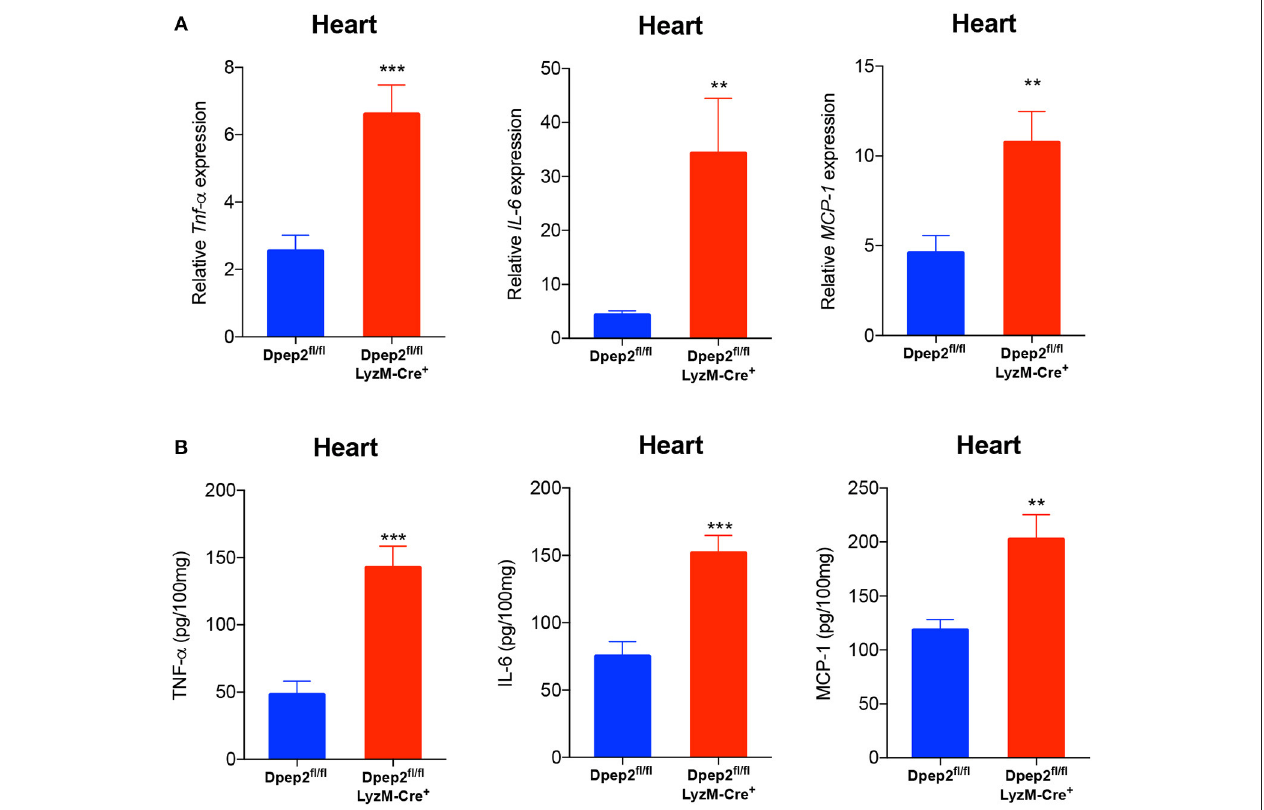
FIGURE 3 | Conditional knockout of Dpep2 in macrophages could markedly promote pro-inflammatory cytokine production in vivo . (A) Heart tissue homogenates were prepared on day 7 post CVB3 infection, and the levels of pro-inflammatory cytokines including TNF- α , IL-6, and MCP-1 were detected by real-time PCR. (B) Heart tissue homogenates were prepared on day 7, and the levels of pro-inflammatory cytokines including TNF- α , IL-6, and MCP-1 were detected by ELISA. Individual experiments were conducted three times with similar results and the representative data were shown. Data were presented as the means ± S.E.M. ** p < 0.01; *** p < 0.001.